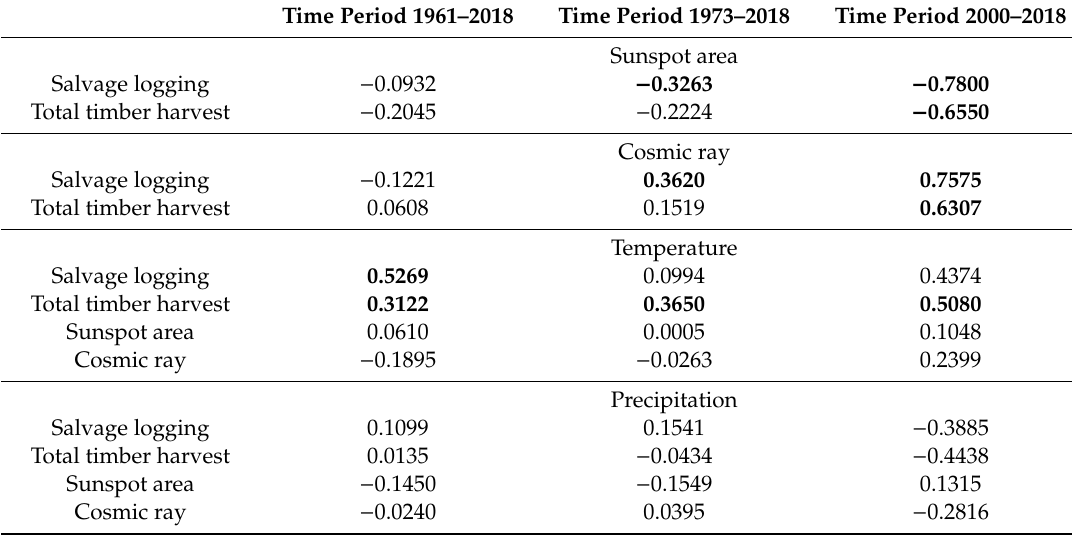
Table 1. Correlation coe ffi cients of salvage logging and total volume of harvested timber with sunspot area, cosmic ray intensity, average air temperatures, and average precipitation total; data are divided into time periods; significant results at p < 0.05 are in